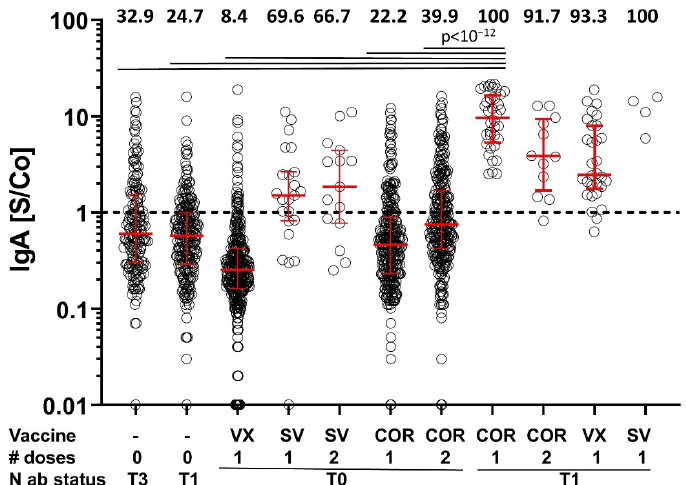
Figure 5. IgA antibody levels. Shown are IgA signal to cut-off ratios (S/Co) for serum samples from the indicated groups of participants. Numbers on top of the graph give the percentage of IgA-positive participants of each group. Fisher’s exact tests were used for pairwise comparison of all groups without correcting for multiple testing (see Supplementary Table S5) and judged at Bonferroni-corrected significance of 0.05/55 = 9.09 × 10 − 4 . For clarity reasons, highly significant differences ( p < 10 − 12 ) between groups are only shown for comparisons of participants that were N-antibody (ab) seropositive at the June 2020 time point (N ab status: T1) and vaccinated once with Comirnaty (COR). T3: participants negative for N antibodies at the June and November 2020 visits, but positive at the April 2021 visit. N ab status: T0: participants seronegative for N antibodies at all study time points analyzed. VX: Vaxzevria; SV: Spikevax; The dashed line separates IgA seropositive from seronegative samples. Supplementary Tables S5 and S6 provide p -values of all pairwise comparisons as well as number of participants, basic demographic characteristics and the median time interval between the last immunization and blood sampling. # doses indicates the number of applied doses. When comparing the percentage of IgA positives of uninfected individuals vaccinated twice with COR to one-time vaccinated individuals with infection >9 months ago (39.9% and 100%, respectively), we found a significant difference (exact Fisher’s test p < 10 − 20